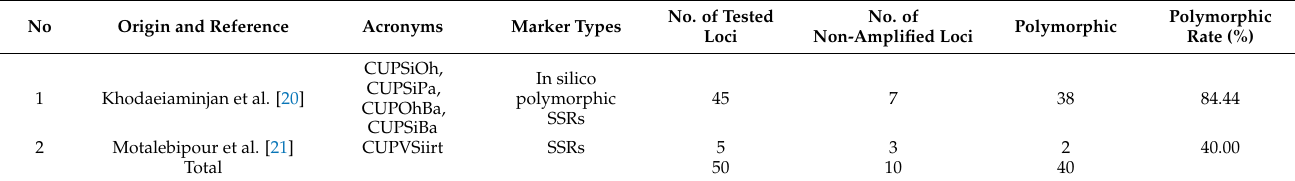
Table 2. Summary of all SSR primer pairs developed from pistachio in Pistacia terebinthus